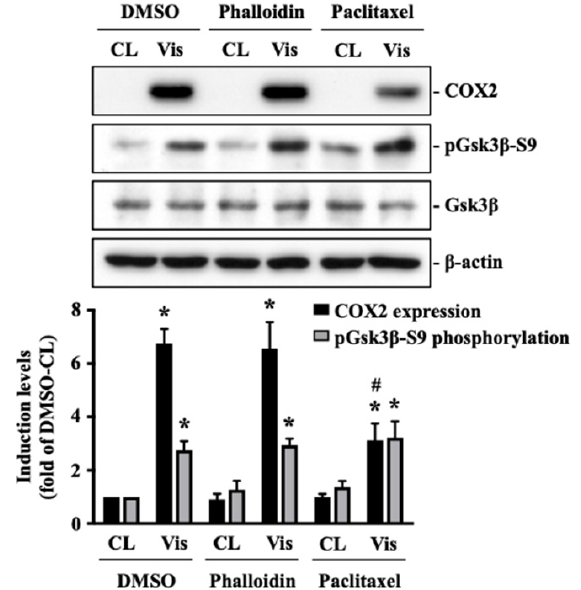
Figure 5. Microtubule network damage influences the visfatin catabolic effect on COX2 upregulation in human primary chondrocytes. Human primary chondrocytes were pretreated with DMSO, phalloidin (microfilament stabilizer, 3 µ M), or paclitaxel (microtubule stabilizer, 1 µ M) for 1 h and then kept as controls (CL) or treated with 5 µ g/mL of visfatin (Vis) for 8 h. COX2 expression and GSK3 β -Ser9 phosphorylation in human primary chondrocytes were analyzed by Western blot. Results are representative of three independent experiments with similar results. Statistic data are mean ± SEM from three independent experiments. *, p < 0.05 vs. DMSO-CL-treated cells. #, p < 0.05 vs. DMSO-visfatin (Vis)-stimulated